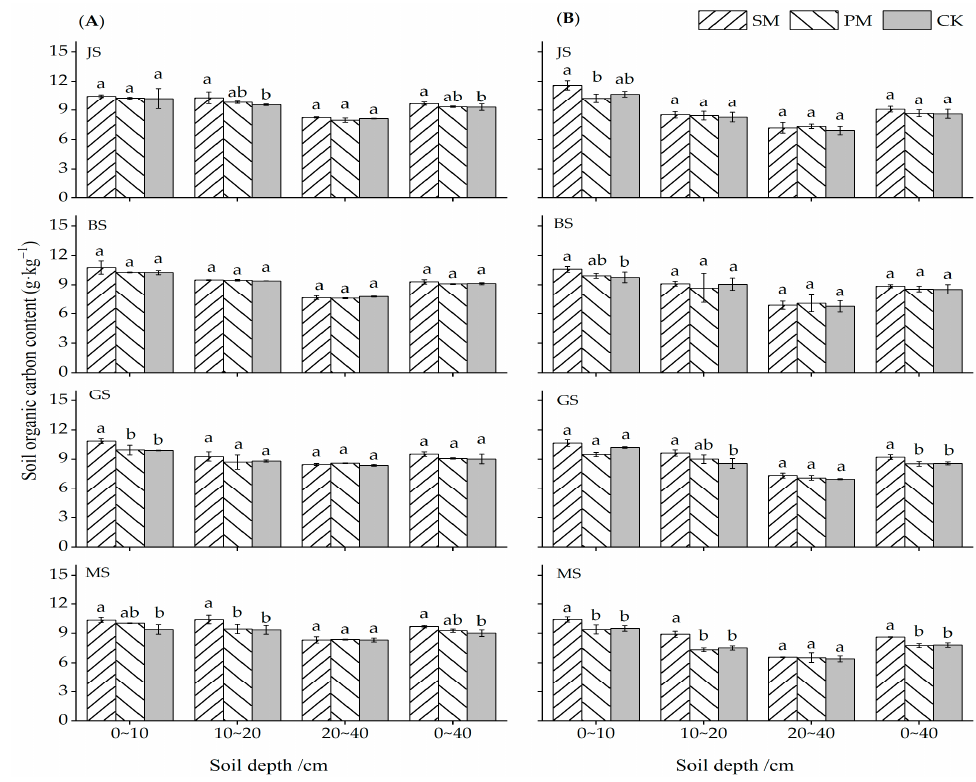
Figure 1. Soil organic carbon (SOC) contents in different growing periods of winter wheat. ( A )